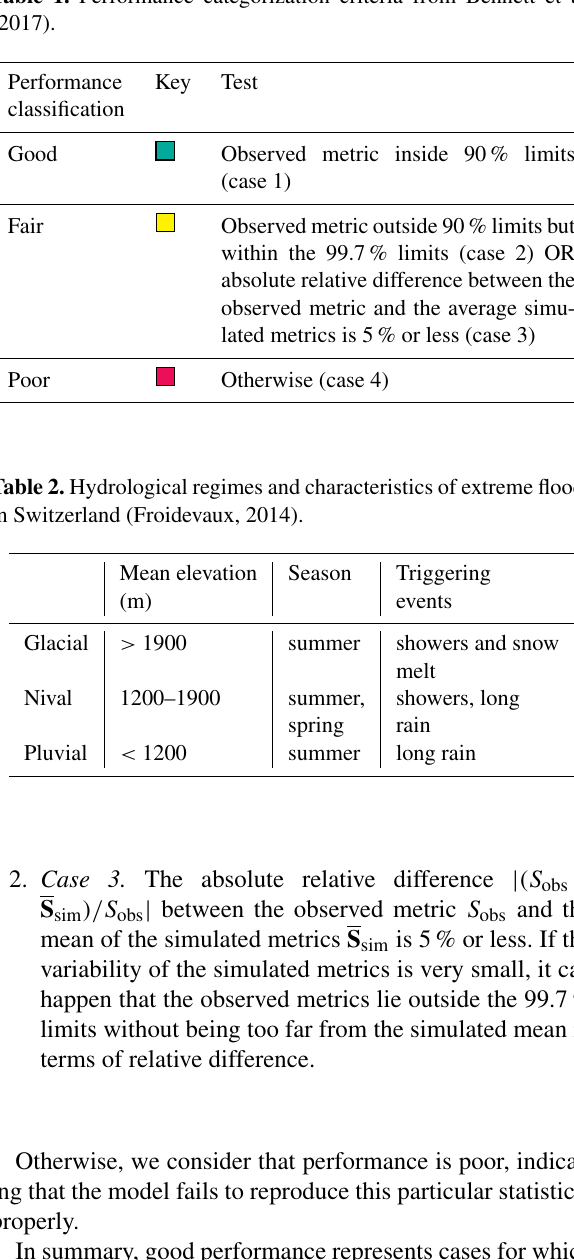
Table 1. Performance categorization criteria from Bennett et al.